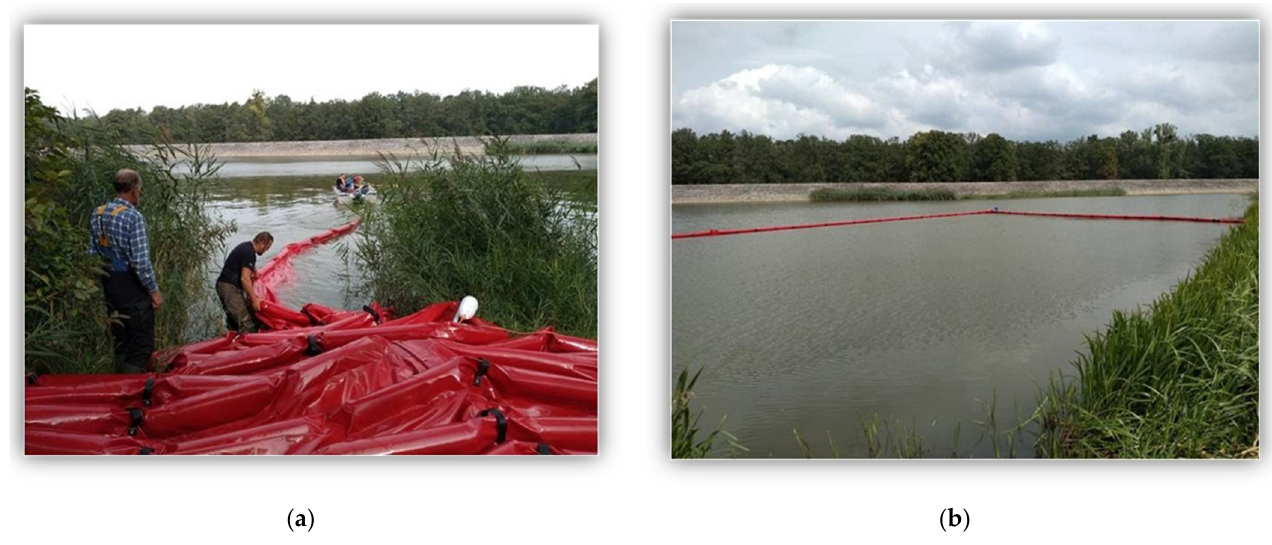
Figure 1. Photo of ( a ) the anti-spill floating dam assembly and ( b ) the studied area. In August 2021, a total of 54 water samples were collected from the reservoir. Sam- pling was carried out on dry days. Water samples were taken from three selected points (A, B, C) 10 m apart (Figure 2) of the study area (50°43 ′ 28.9 ′′ N, 18°07 ′ 01.1 ′′ E) in three replications once a week for three consecutive weeks–09.08.2021 (I–control date, before EM application), 16.08.2021 (II–second sampling date), and 24.08.2021 (III–third sampling date). At each point, the samples were taken at a depth of 30 cm below the water surface using a water sampler (Denios). Water samples for microbiological and physicochemical analyses were collected in sterilized plastic bottles with a capacity of 500 mL. After sam- pling, all water samples were immediately placed in a transport refrigerator, transported to the laboratory, and stored at 4 °C. Microbiological and physicochemical analyses were performed within 24 h of taking the samples.